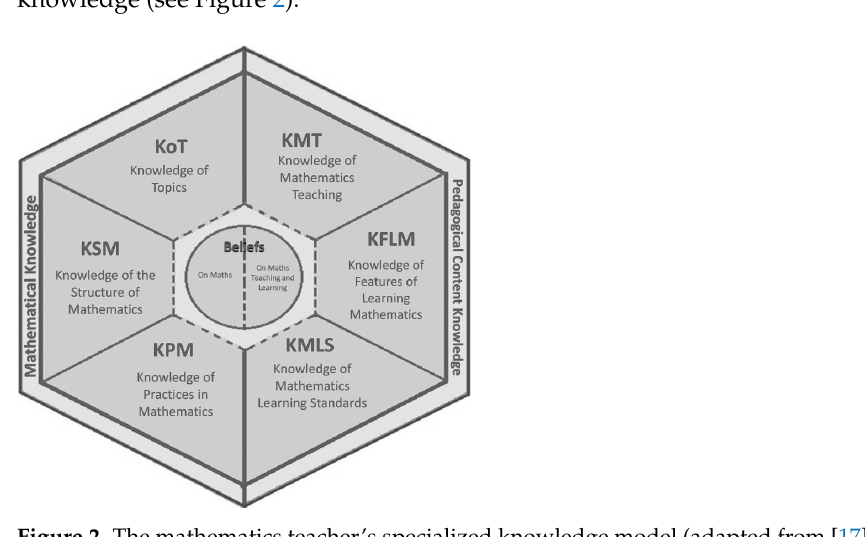
Figure 2. The mathematics teacher’s specialized knowledge model (adapted from [17] (p.